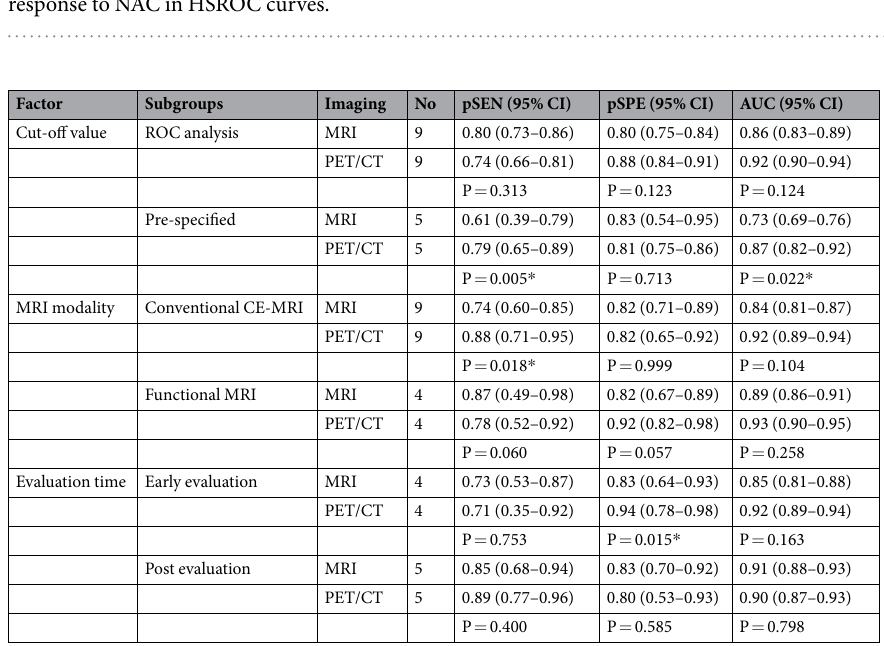
Figure 4. Pairs of observed values of sensitivity and specificity for MRI and PET/CT to assess pathologic response to NAC in HSROC curves.